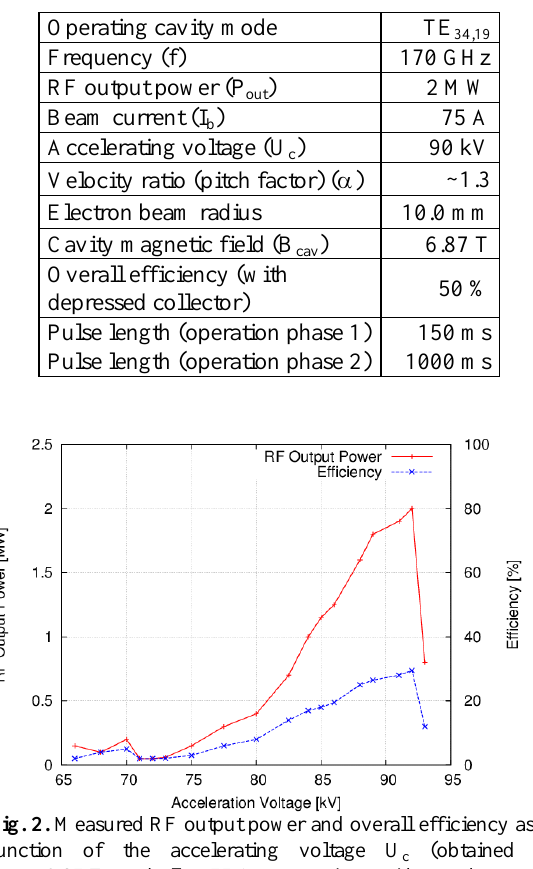
Table 1. Design parameters for the coaxial-cavity short pulse gyrotron.